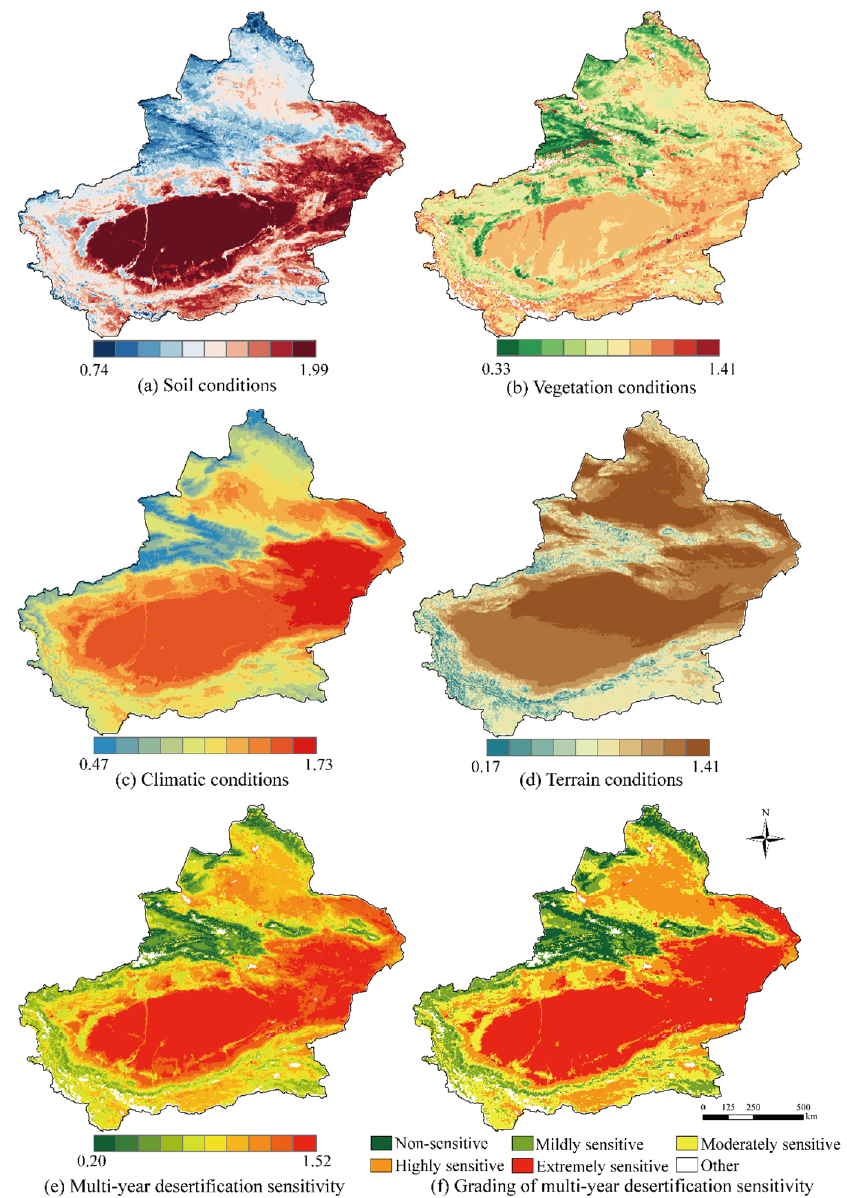
Figure 3. Spatial distribution of fi rst-level indicators, deserti fi cation sensitivity, and its classi fi cation.